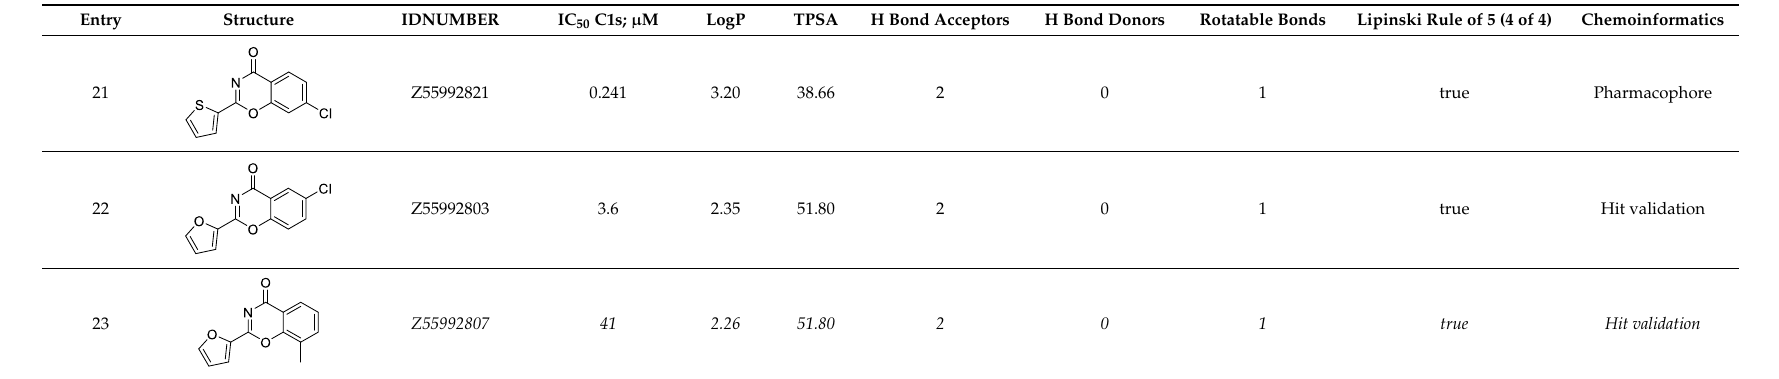
Table 5. Hit compounds derived from the 1,3-benzoxazin-4-one chemotype.